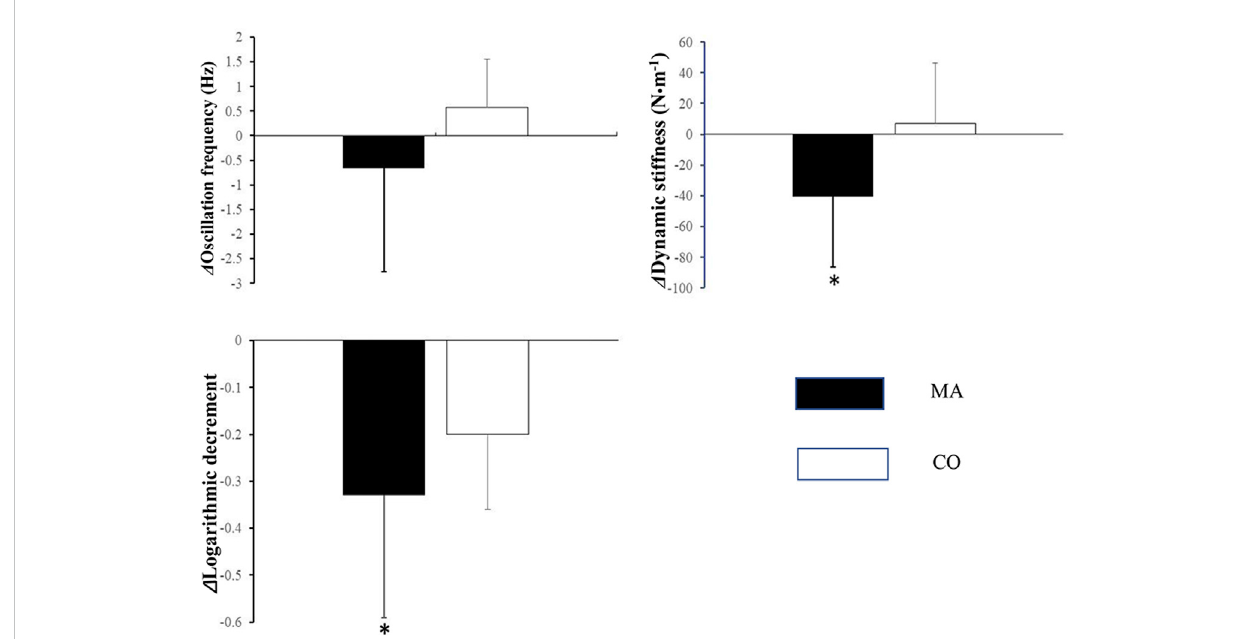
FIGURE 3 The change amplitude of physical properties of erector spine measured using Myoton Pro in MA and CO group after two-week intervention. (*: Signi fi cant difference compared with CO group, P < 0.05).